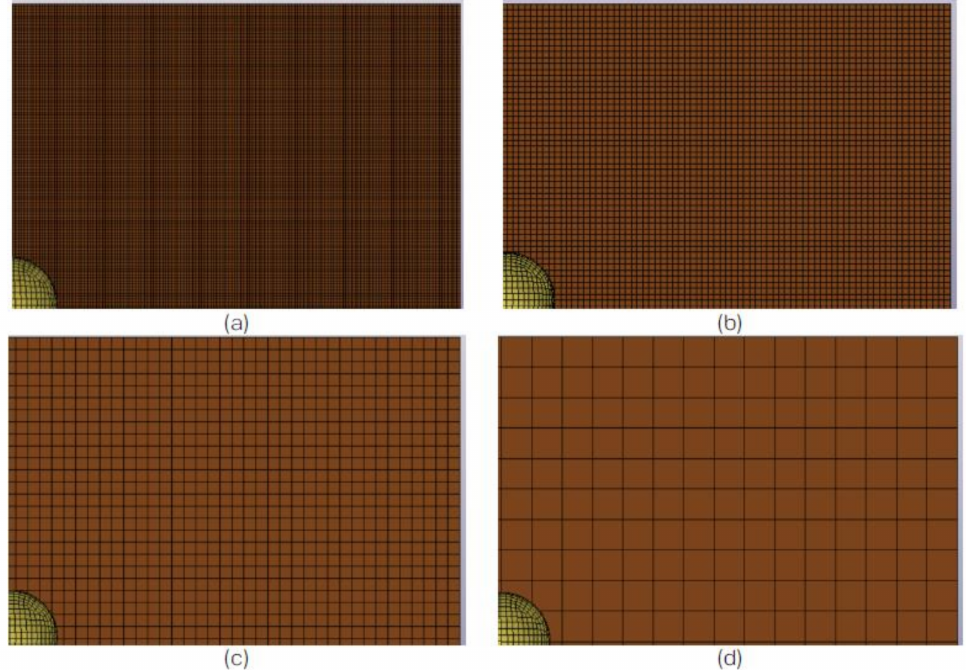
Figure 11. View of a quarter of the FE model for the LVI panel created with different mesh/element